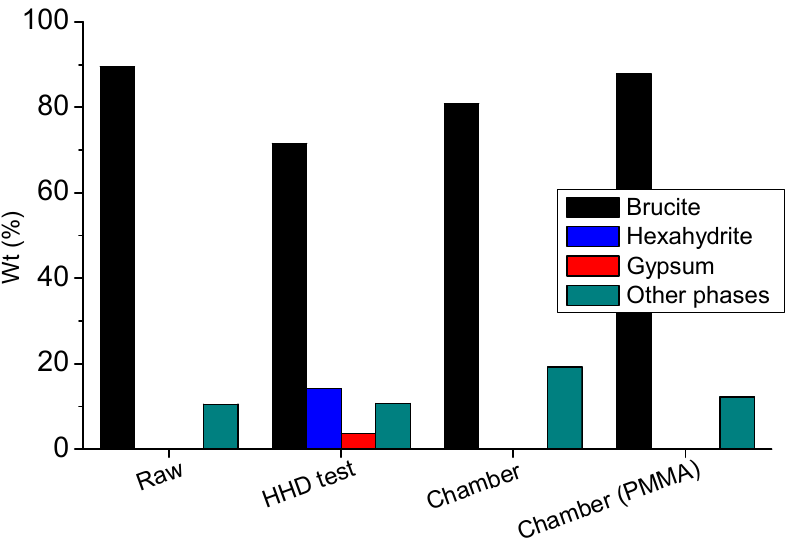
Figure 11. The semi-quantitative results of XRD analysis, regarding the presence of crystalline phases for the coated specimens after 4 days of each acid spraying test applications; «raw» is the coating but without being subjected to spraying applications.